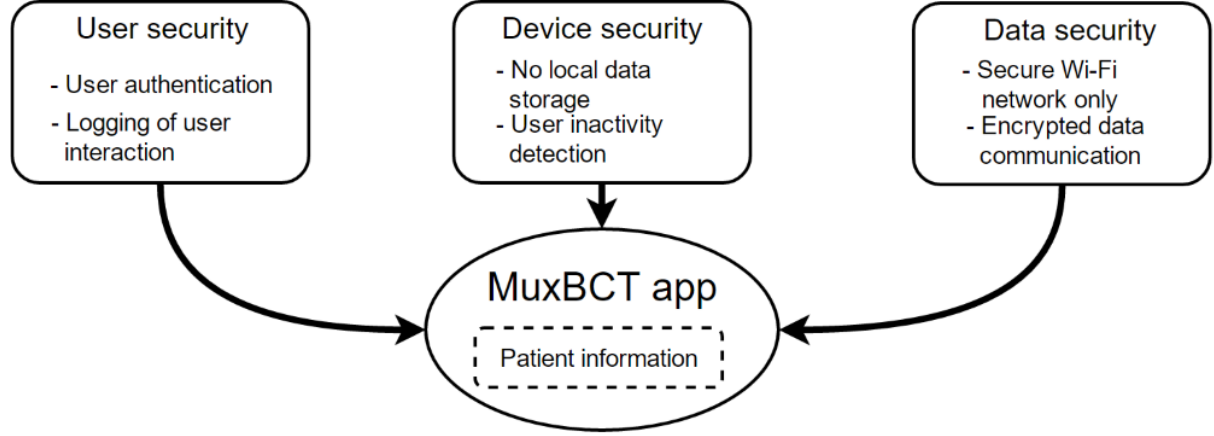
Figure 4. Overview of the security design considerations that in unison protect the patient information of the Multiplex Blood Culture Test (MuxBCT) application (app). It is a requisite that the security considerations are implemented before the deployment of the MuxBCT app. Wi-Fi is the local wireless